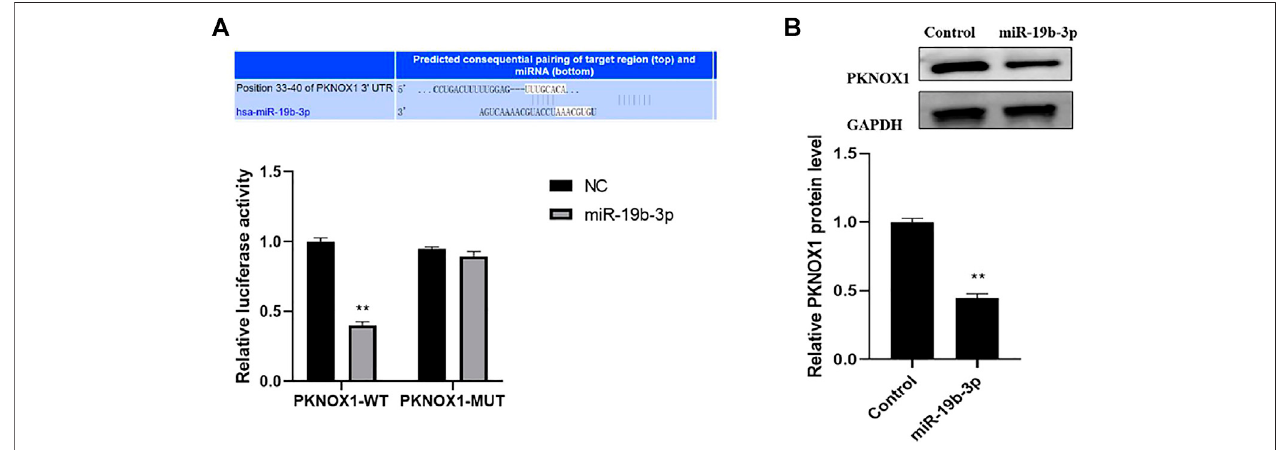
FIGURE 4 | Comparison of luciferase activity under different treatments. (A) Bioinformatic analysis prediction and dual luciferase reporter gene validation of the binding of miR-19b-3p to PKNOX1 3 ′ -UTR. (B) Western blot was used to detect the expression of PKNOX1 protein in BMDM after different transfections. Compared with the control group, p p < 0.05, pp p < 0.01, ppp p <